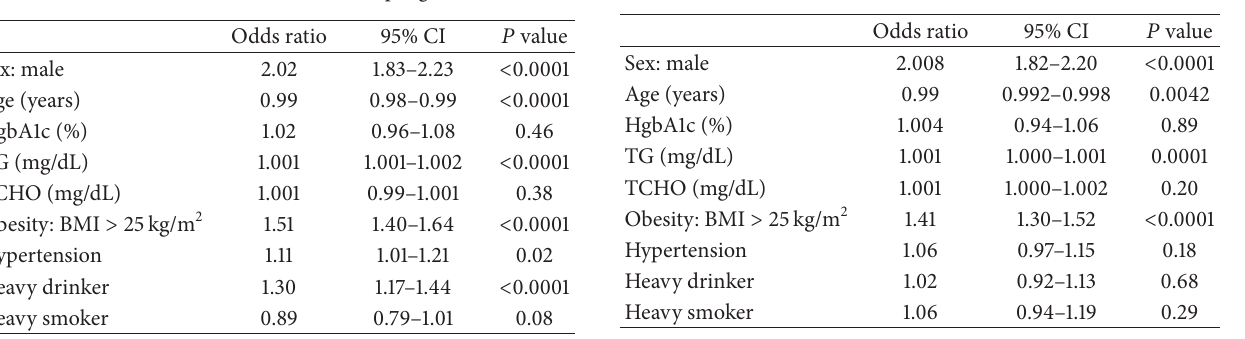
Table 2: Predictors for reflux esophagitis. Table 3: Predictors for hiatal hernia.